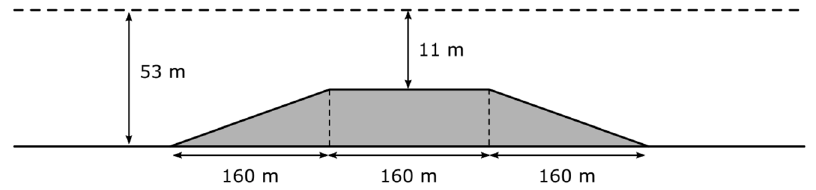
Figure 5. The shoal is symmetric above the flat bottom and has a trapezoid shape. The slope on each side is approximately 1:4.